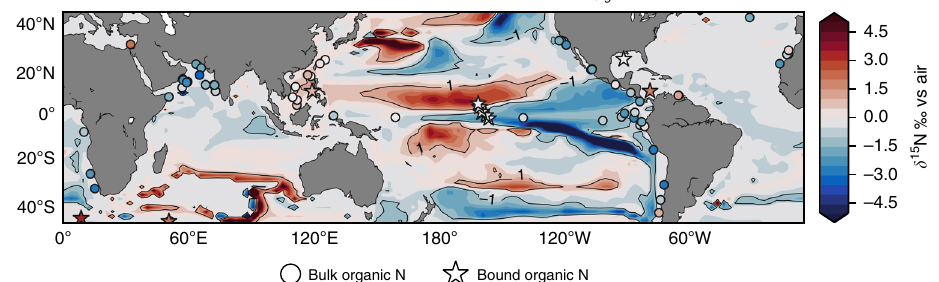
Fig. 4 Seeking evidence from sedimentary δ 15 N org records. Shading depicts the simulated change in δ 15 N of organic matter as a result of increasing aeolian Fe supply from the modern to a glacial rate. Solid and dashed contour lines mark simulated differences of 1 and − 1. Circles mark locations of sediment cores where bulk organic matter was analysed for δ 15 N, while stars mark locations where either foraminifera- or diatom-bound δ 15 N was measured. The colour of the markers is an estimate of the glacial (Last Glacial Maximum: 20,000 – 26,000 BCE) minus interglacial (Late Holocene: 0 – 5000BCE) difference in δ 15 N org , with red colours representing higher values and blues representing lower values in the glacial ocean. Sedimentary record data are provided in